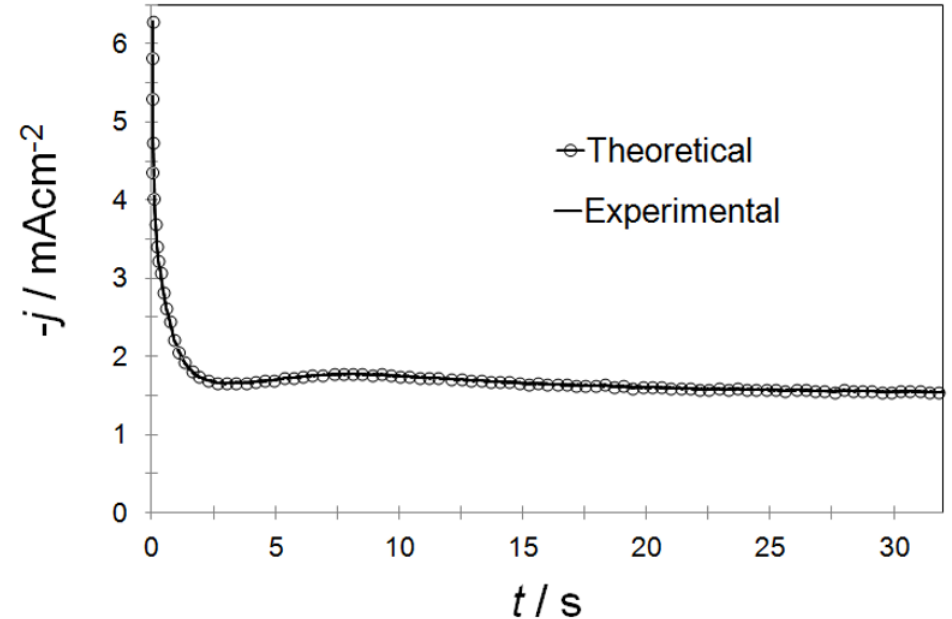
Figure 7. Comparison of an experimental current density transient (—) during cobalt electrodeposition at -1060 mV onto a polycrystalline gold from an aqueous solution containing 0.01M CoSO + 1 M (NH ) SO at pH=7 and a theoretical transient (open circles) obtained by 4 4 2 4 non-linear fit of Eq. whole experimental current transient behavior. Similar fittings were obtained for the other transients shown in Fig. 6. The parameters obtained from the adjustments are summarized in Table 1. Since k , A and N values PR 0 increase as the applied potential becomes more negative, the proton and cobalt reduction processes become favored at higher overpotentials.